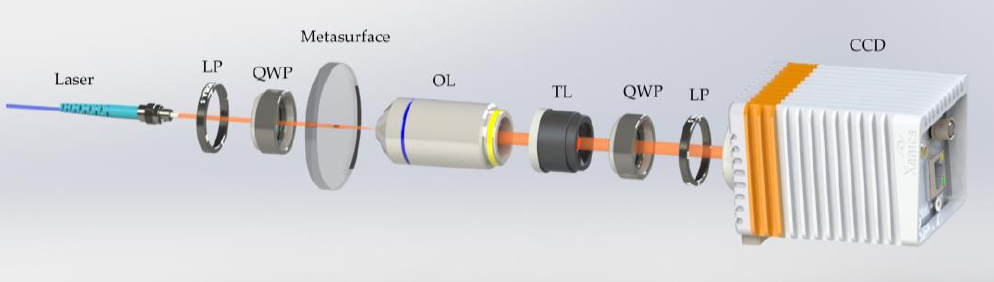
Figure 3. Schematic of the optical setup for the experimental validation. LP (linear polarizer); QWP (quarter-waveplate); OL (objective lens); TL (tube lens); CCD (charge-coupled device camera).